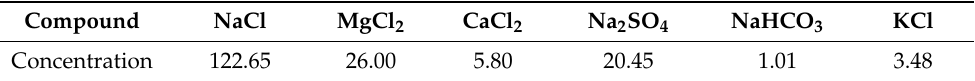
Table 3. Chemical proportion of a concentrated artificial seawater